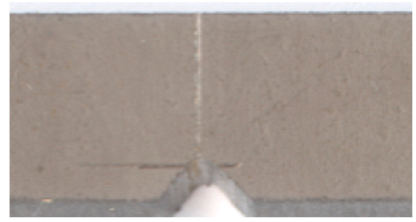
Figure 10. Shape of the cut on a specimen.